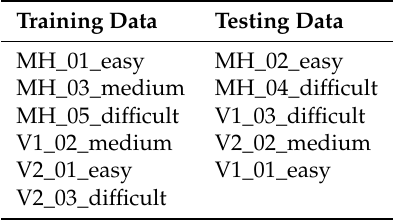
Table 2. Train and test splits of EuRoC MAV